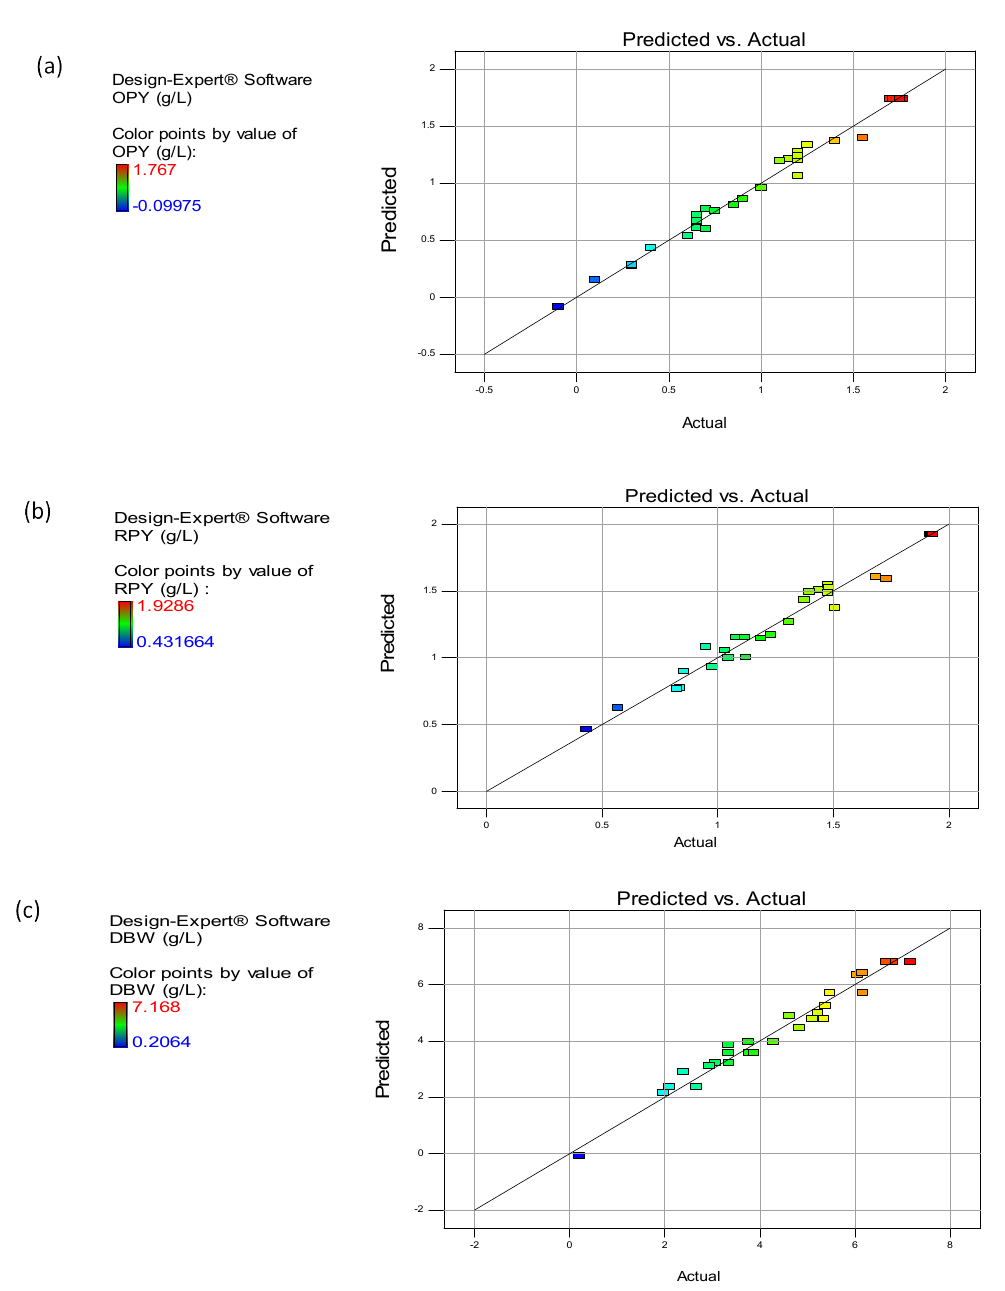
Figure 4. Validation of the polynomial model for ( a ) OPY, ( b ) red pigment yield (RPY), and ( c ) dry biomass weight (DBW) productions from Talaromyces albobiverticillius 30548.